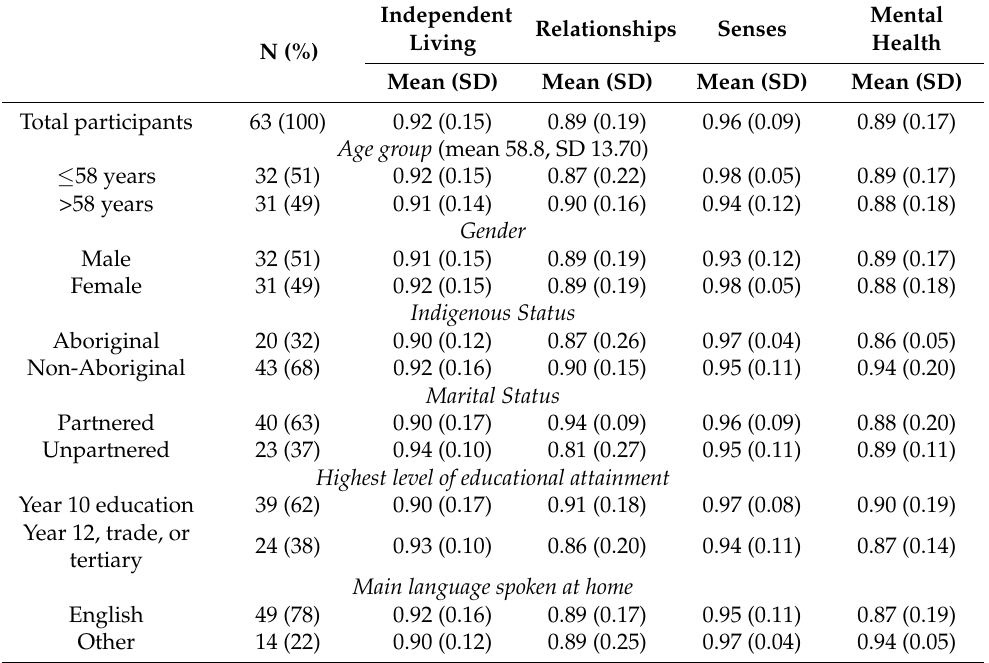
Table 1. AQoL-4D dimension scores by characteristics in cancer survivors in their first year of diagnosis, NT, Australia. Independent Relationships Senses Living N (%)